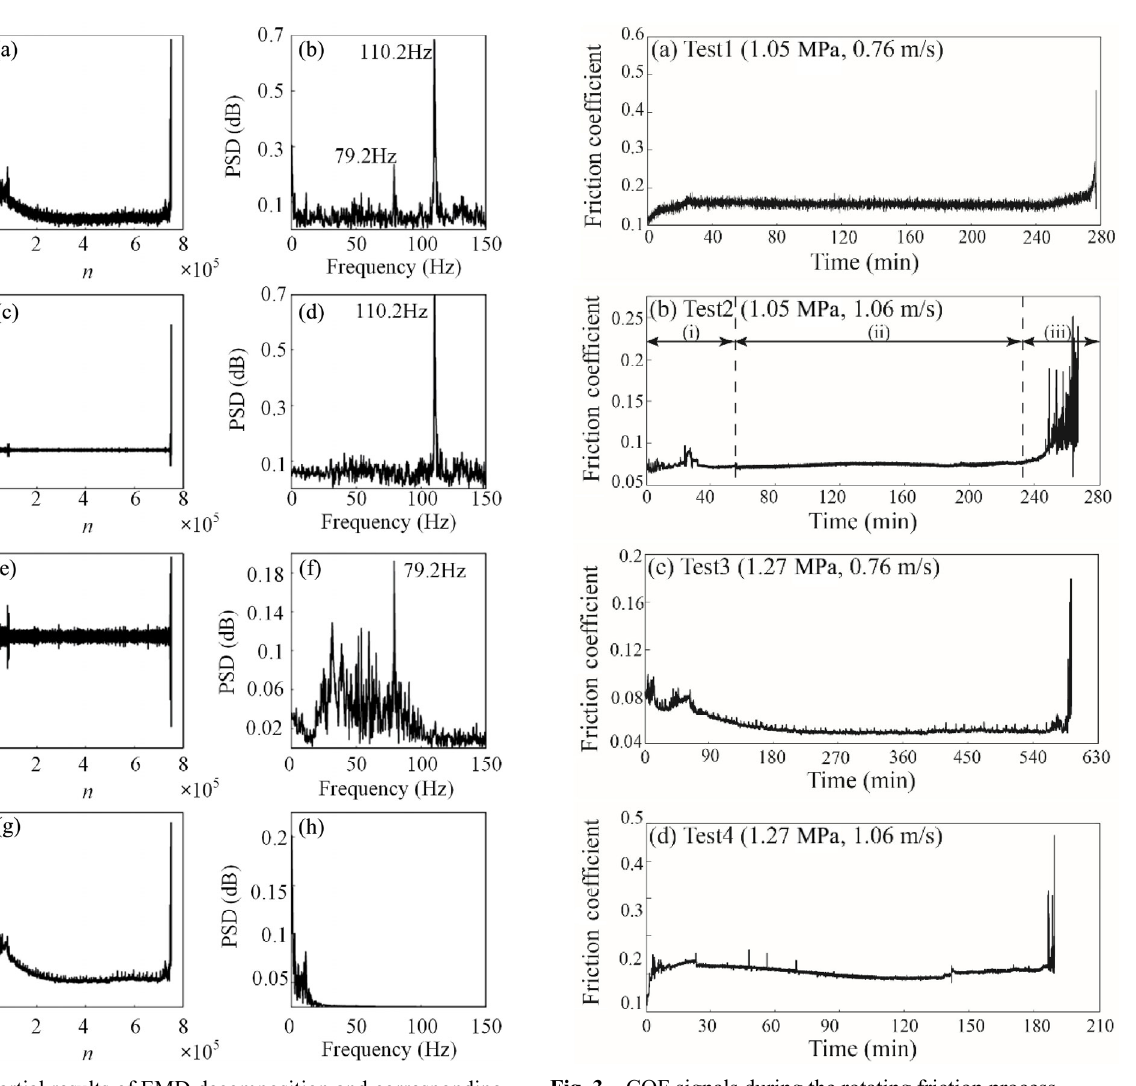
Fig. 2 Partial results of EMD decomposition and corresponding PSD spectra graph.